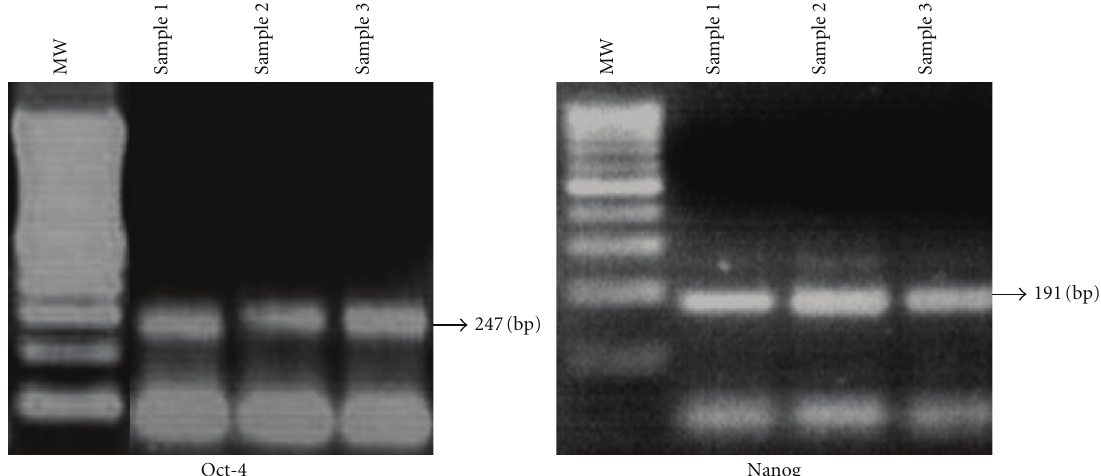
Figure 2: Undi ff erentiated gene expression (Oct-4 and Nanog). AFSCs total RNA was extracted from 3 di ff erent samples by Trizol method, gene expression evaluated by RT-PCR, and electrophoresed and visualized under ultraviolet light in 2% agarose gel stained with ethidium